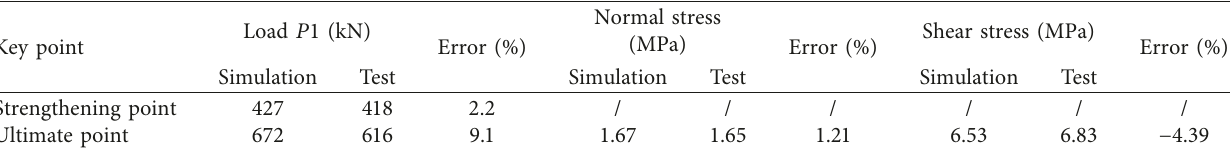
Table 1: Comparison of key points between the numerical analysis and the experiment. Key